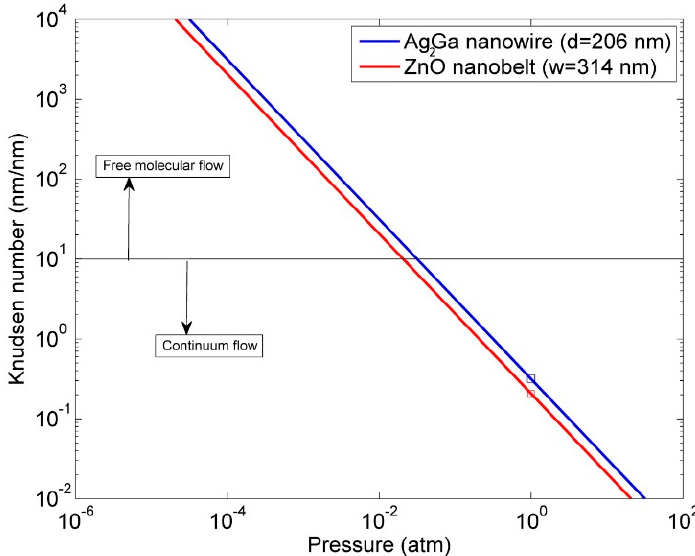
Figure 1. Effect of nanoresonator size and its surrounding pressure in air on the Knudsen number at 300 °·K. The squares show the condition of nanoresonators that are tested in the thermoacoustic model.